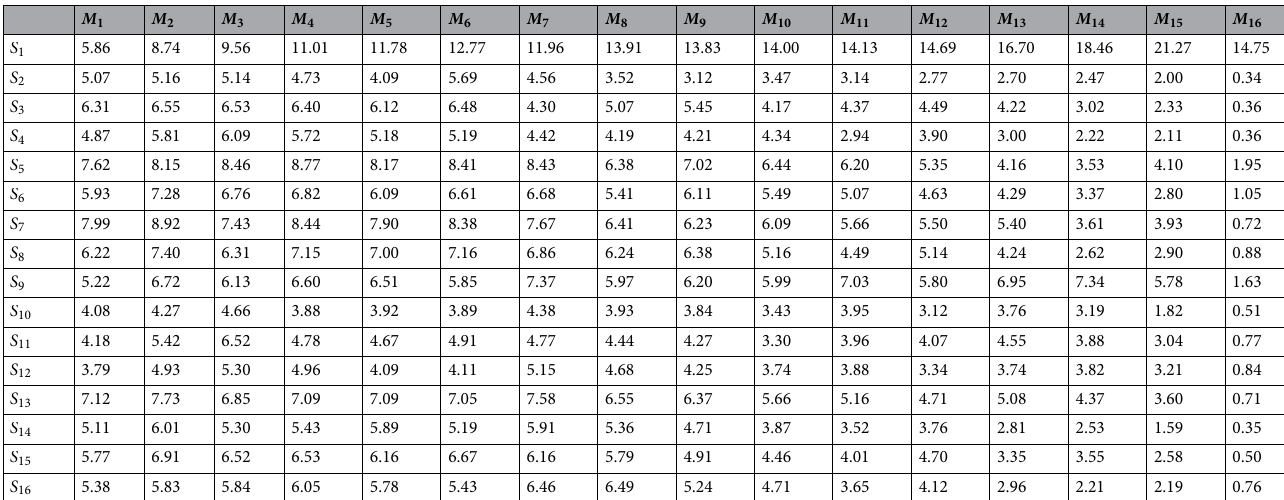
Table 1. Classification accuracies of 16 DL models on a testing sets of 16 subkeys (No change in the number of traces in the training